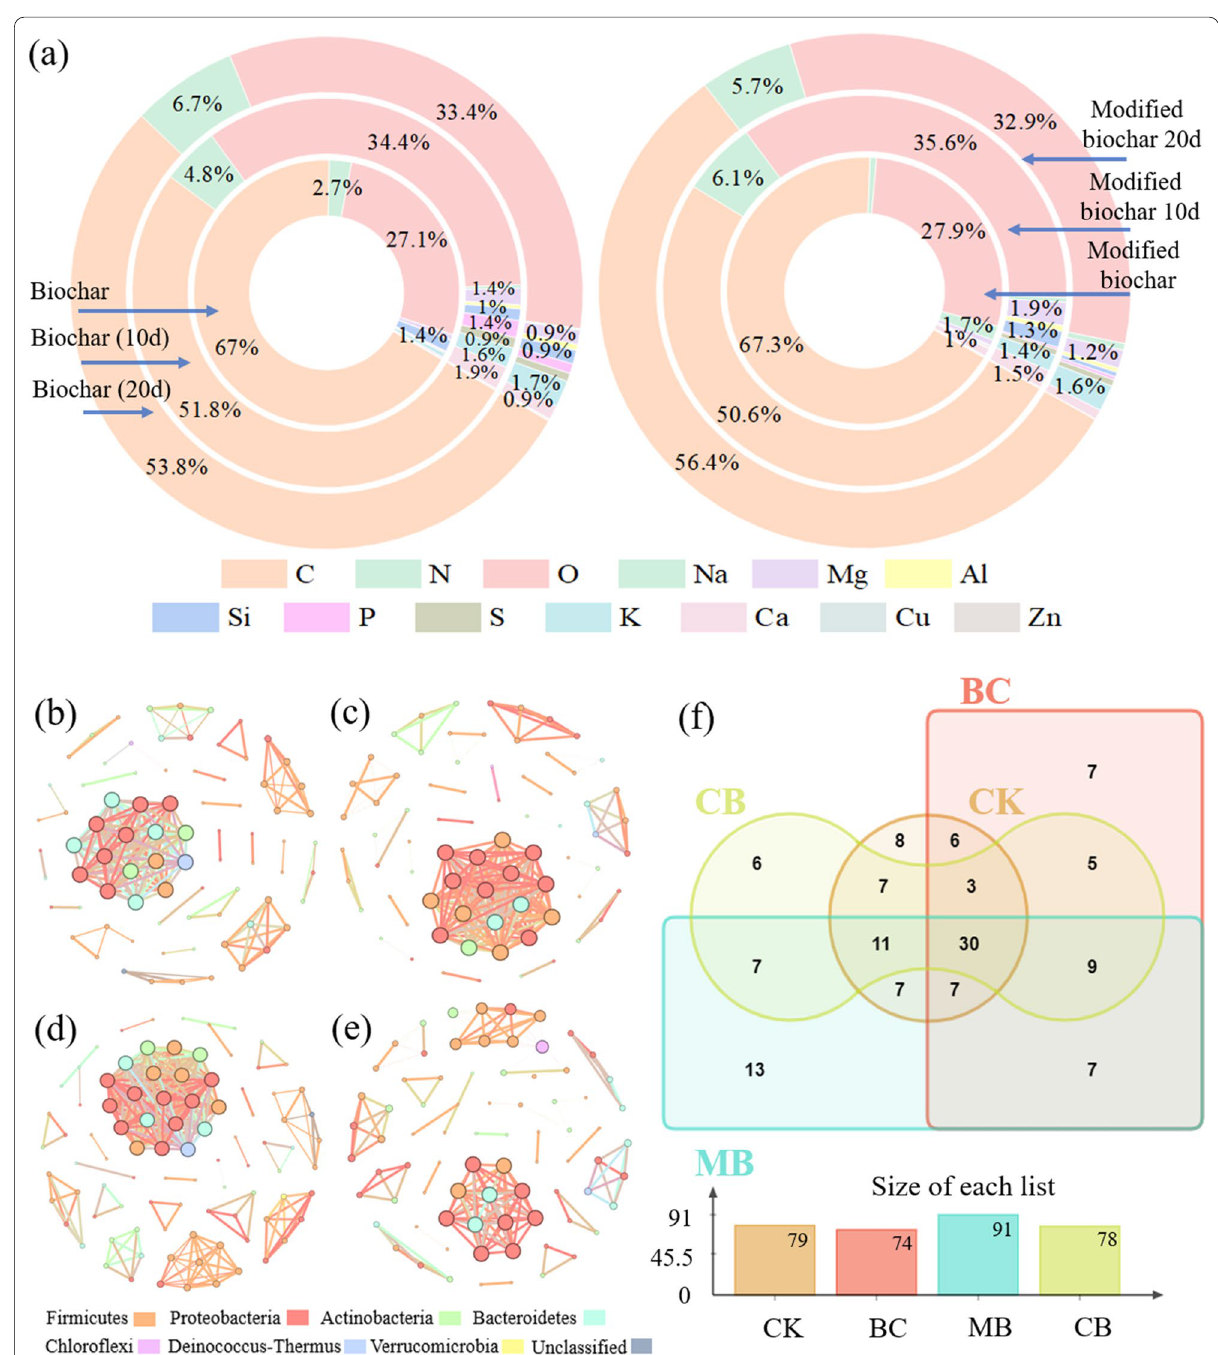
Fig. 4 The element composition of the biochar and modified biochar taken out from composting ( a ). Network analysis between bacteria at genus level during CK ( b ), BC ( c ), MB ( d ) and CB ( e ) composting. Comparison of the differences of predominated bacteria under different treatments with Venn diagrams ( f ). CK CK composting; BC BC composting, MB MB composting, CB CB